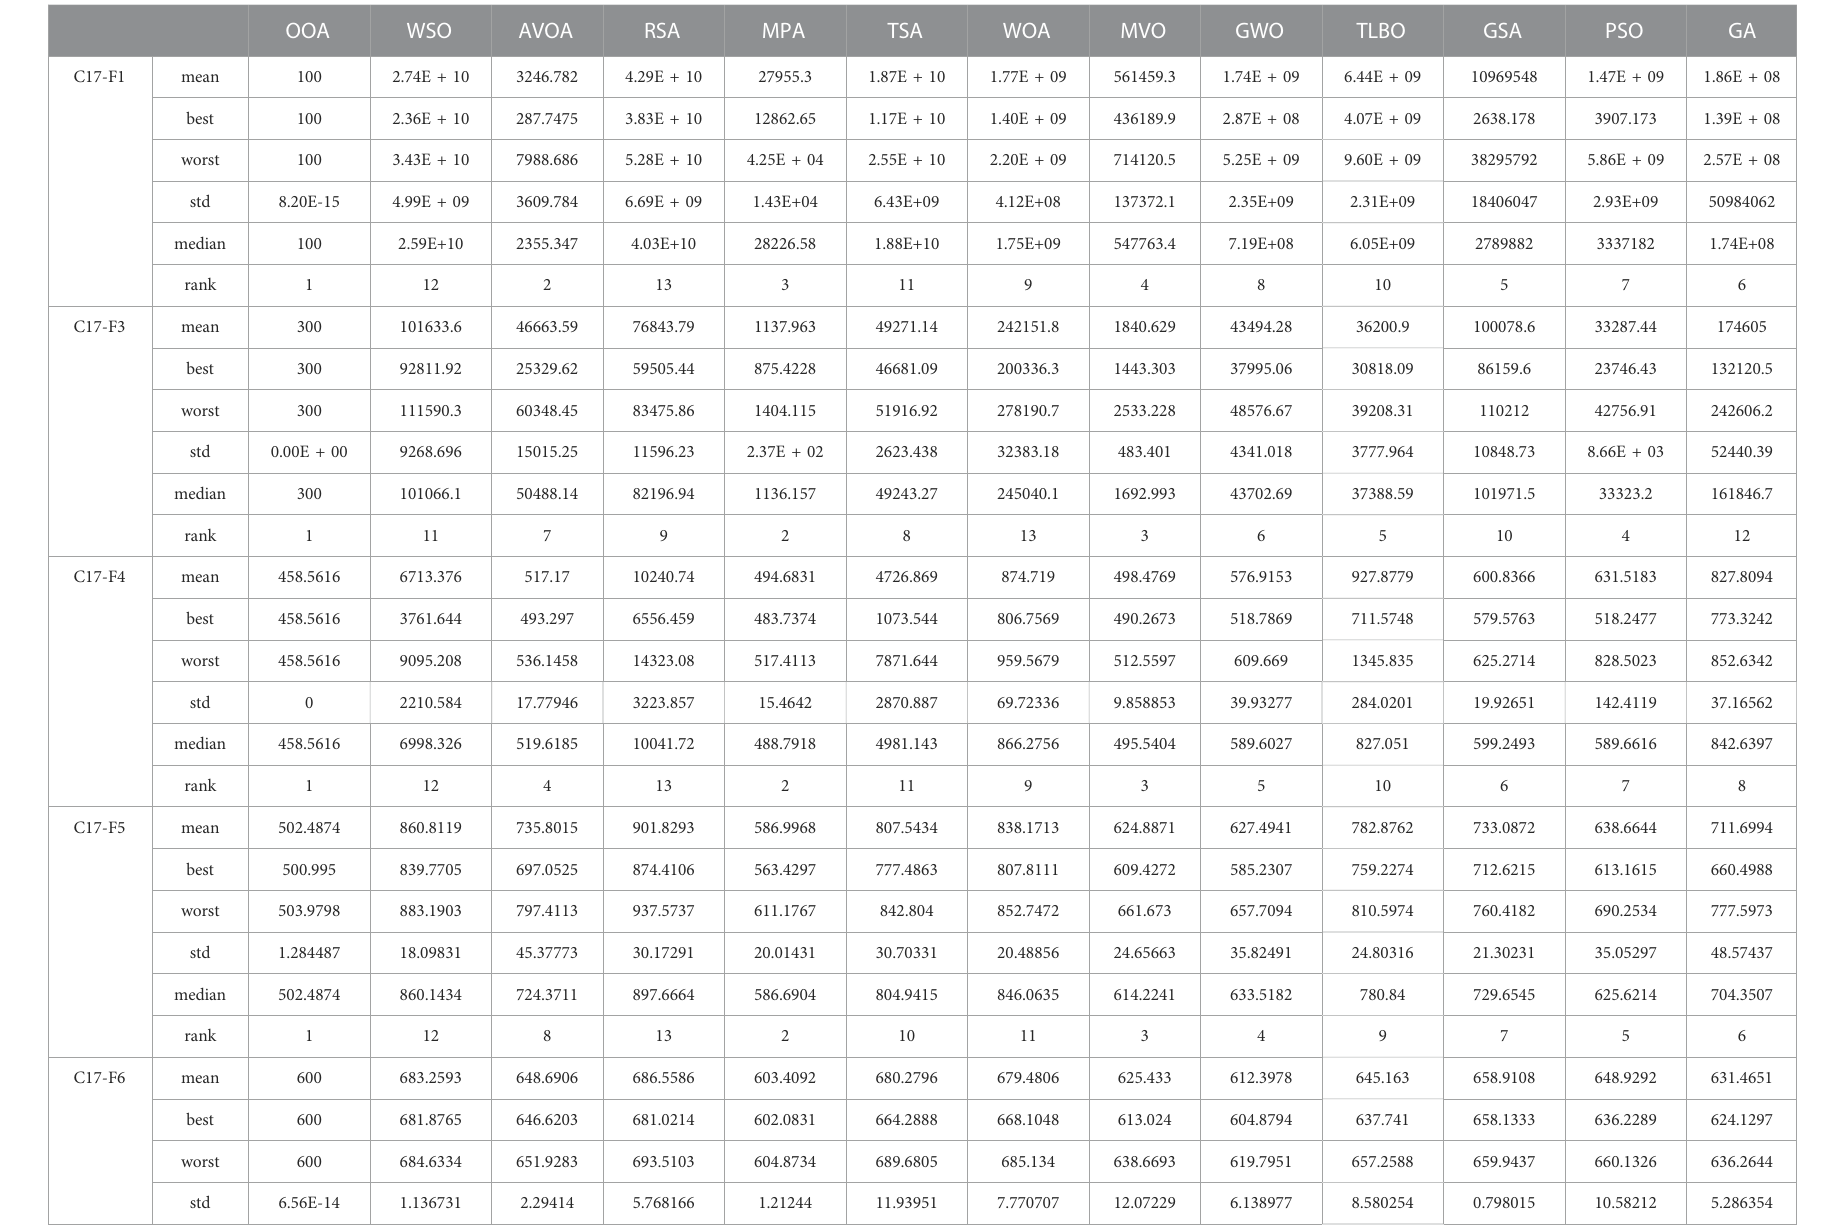
TABLE 3 Performance of optimization algorithms on the CEC 2017 test suite ( D (cid:1) 30